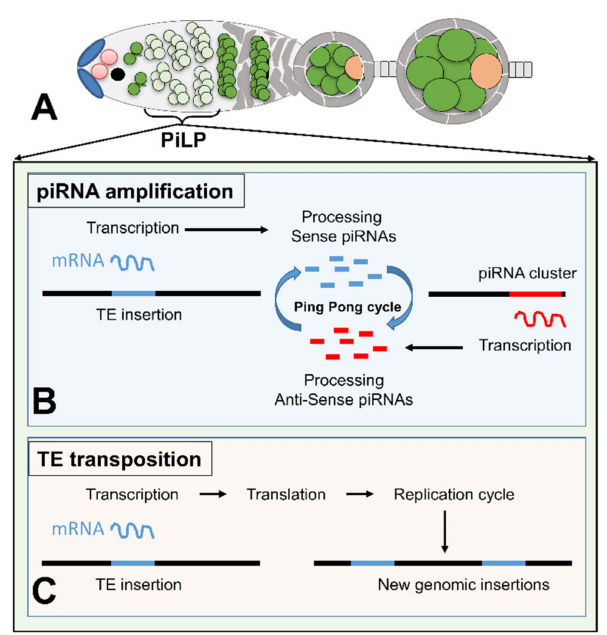
Figure 2. Model of the functional role of the “PiwiLess Pocket” (Pilp). ( A ) Schematic structure of a germarium and early egg chambers. Germline stem cells are in pink, the cystoblast in black, germ cells of the dividing cysts and nurse cells of the egg chambers in green with the Pilp indicated in light green, and the oocyte is in orange. The germinal cells are surrounded by somatic follicular cells (grey). ( B ) In the Pilp, TE transcripts resulting from a decrease of Piwi are processed into piRNAs that boost the ping-pong cycle through their complementarity to transcripts produced from piRNAs clusters (red). ( C ) In the Pilp, TE transcripts engage TEs in a new replication cycle leading to de novo genomic